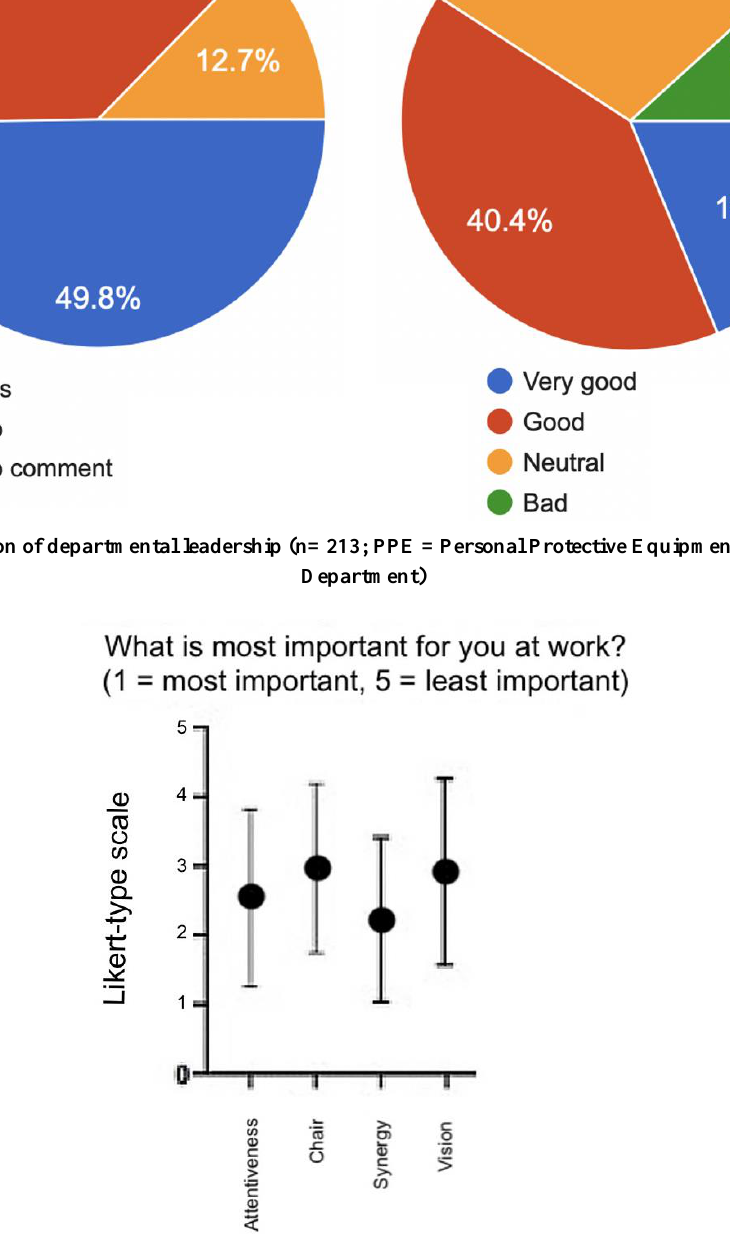
Figure 2. Teams’ preference of leadership